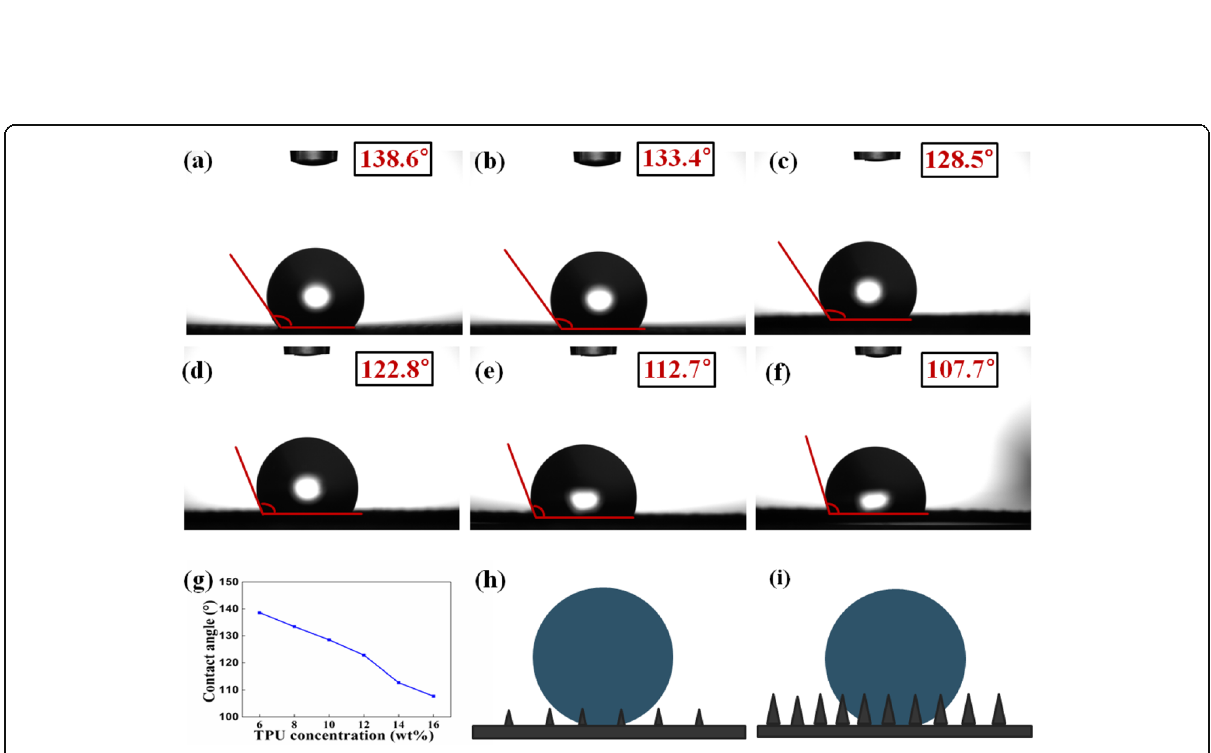
Fig. 6 TPU fiber membrane contact angle characterization. a – f Testing the contact angle of different concentrations of TPU fiber membranes using 5- μ L droplets. g Contact angle of different concentrations of TPU fiber membrane. h – i Droplets on the surface of fibers of different diameters.